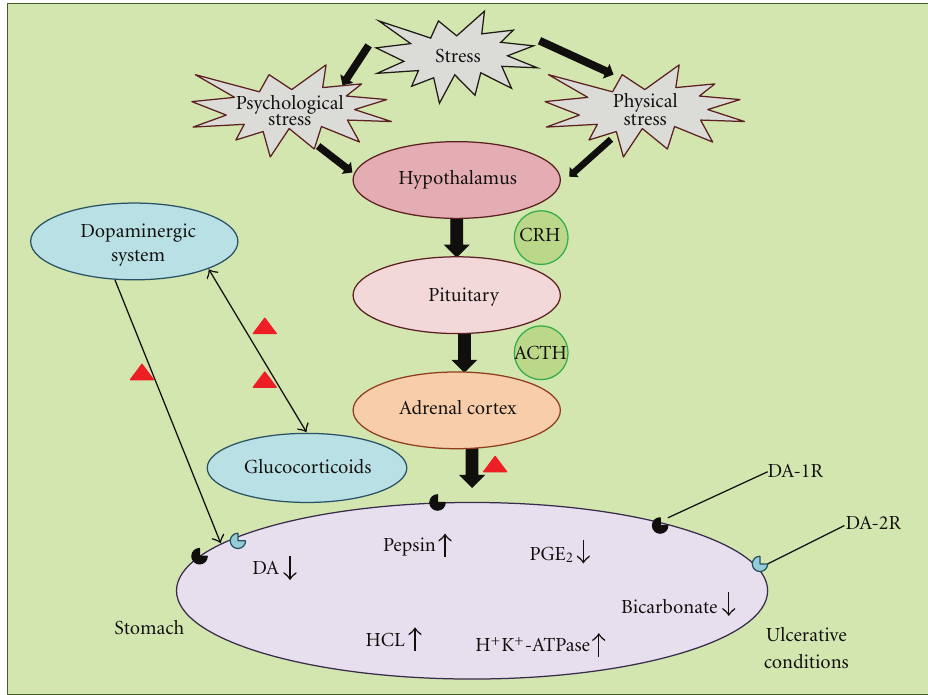
Figure 2: Stress-induced modulations in dopaminergic system and gastric ulcer. Hormonal pathways by which psychological and physical stress induce modulations in stomach functioning, resulting in an increase production of gastric ulceration and modulation of dopaminergic system. Up arrows indicate increased response, down arrows indicate decreased response, triangles indicate possible therapeutic